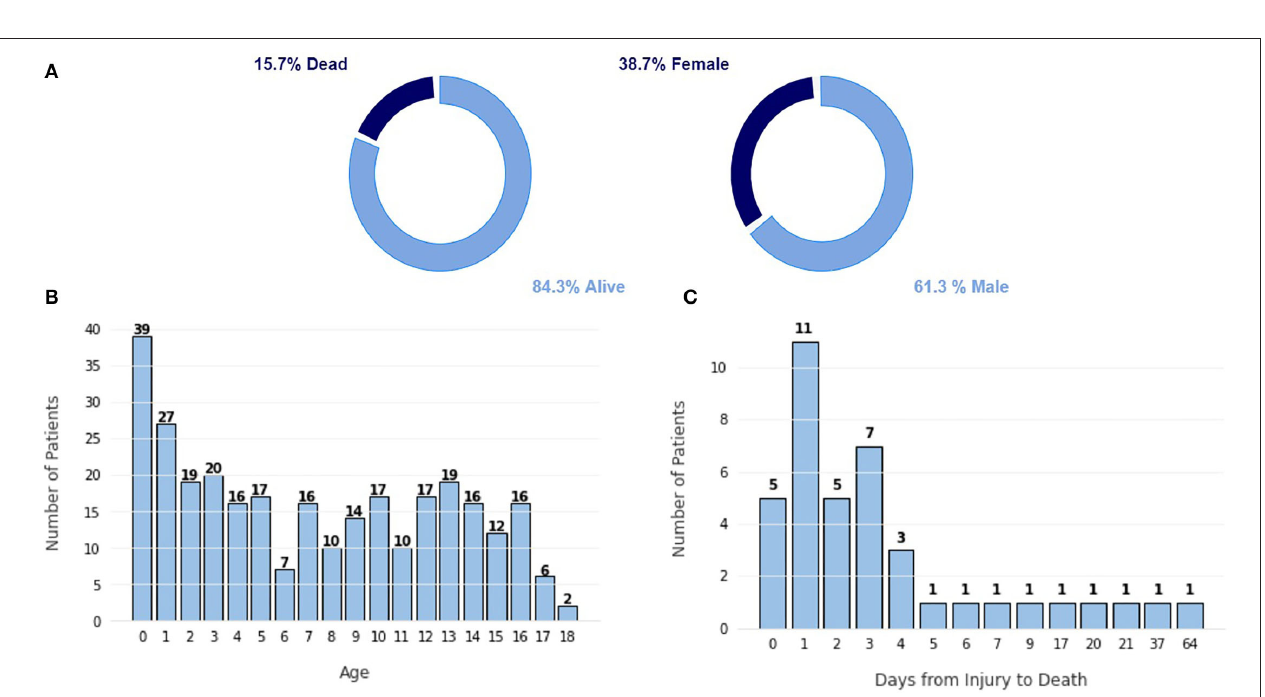
FIGURE 2 | Characterization of the dataset. (A) Proportion of class labels, (B) Frequency plot of the number of patients per age. (C) Frequency plot of the number of patients vs. the number of days since the injury to the death.